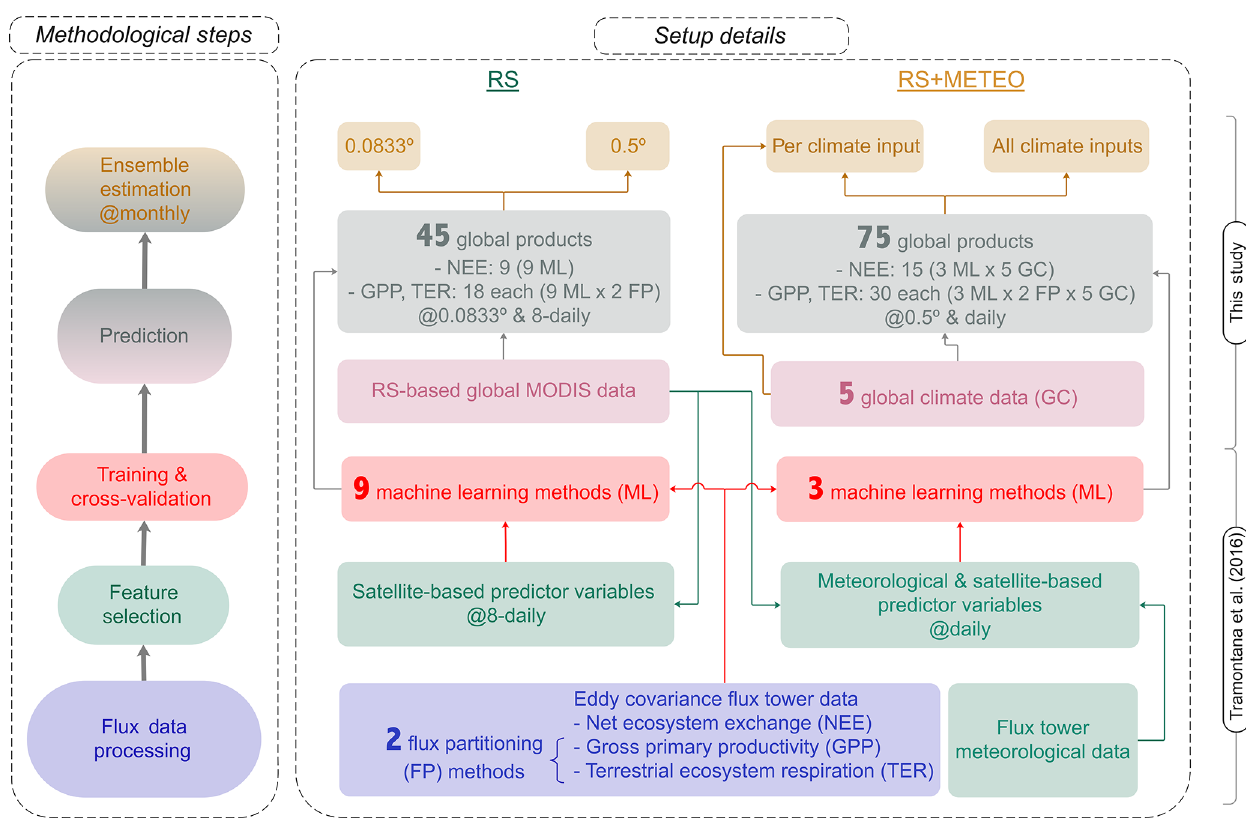
Figure 1. Schematic overview of the methodology and data products from the FLUXCOM initiative. The flow diagram shows the method- ological steps for the remote sensing (RS, left) and the remote sensing and meteorological data (RS + METEO, right) FLUXCOM products. Final monthly ensemble products for NEE, GPP and TER from RS are available at 0.0833 ◦ and at 0.5 ◦ spatial resolution. Ensemble products from RS + METEO are available per climate forcing (GC) data set as well as a pooled ensemble at 0.5 ◦ spatial resolution. All ensemble prod- ucts encompass ensemble members of different machine learning methods (ML, nine for RS, three for RS + METEO) and flux partitioning methods (FP, two for GPP and